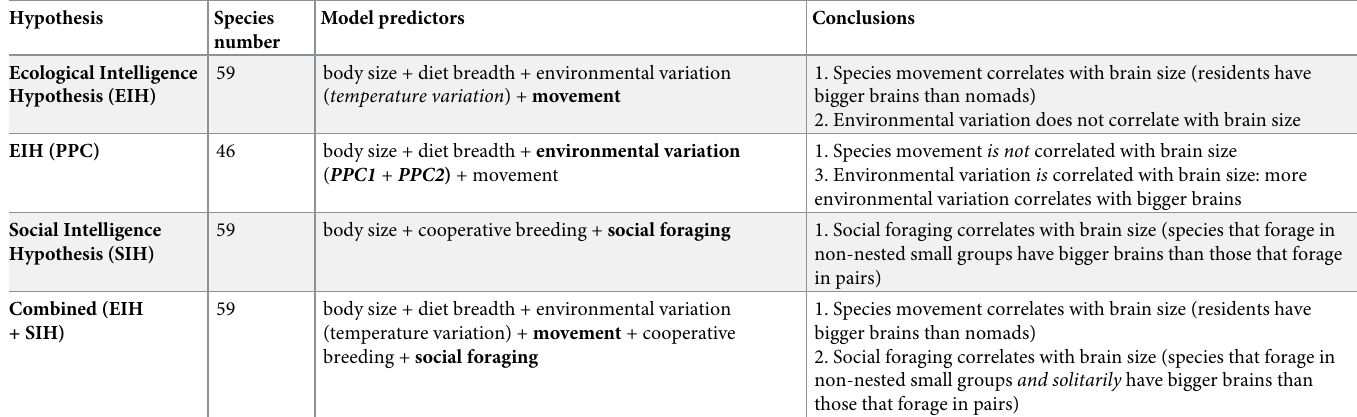
Table 1. Qualitative conclusions drawn from models testing different hypotheses (SIH/EIH/combined). Significant predictors are shown in bold in column